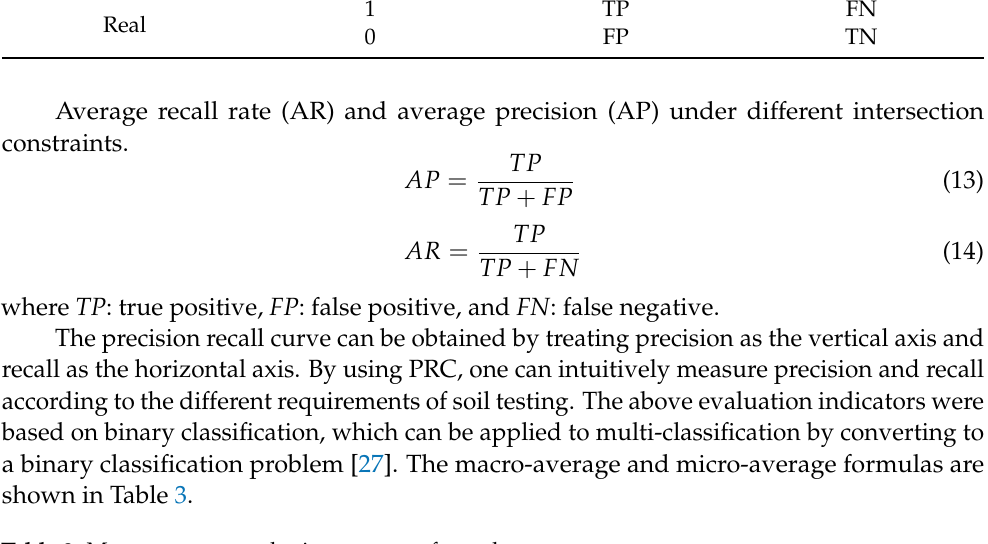
Table 3. Macro average and micro-average formulas.